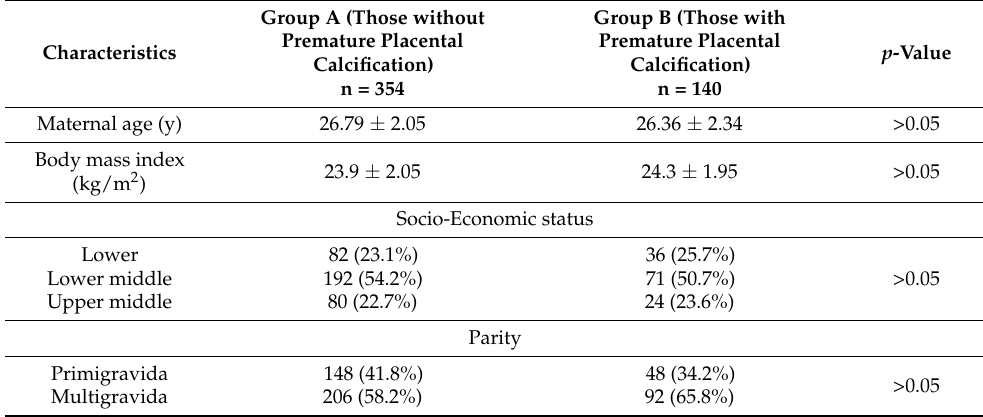
Table 1. Characteristics of women in the two study groups.